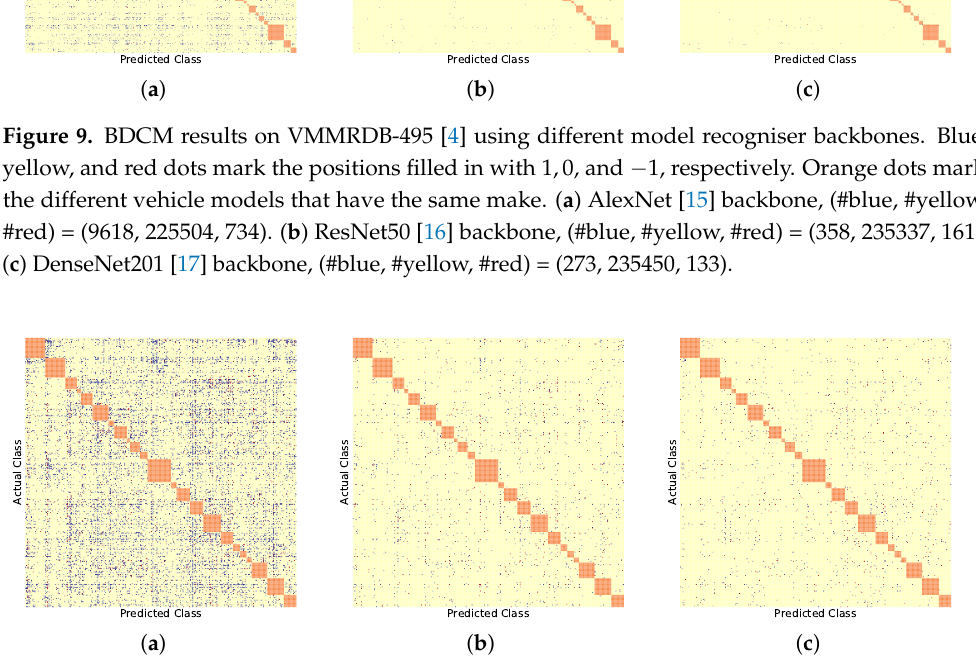
Figure 10. BDCM results on DVMM using different model recogniser backbones. Blue, yellow, and red dots mark the positions filled in with 1,0, and − 1, respectively. Orange dots mark the different vehicle models that have the same make. ( a ) AlexNet [15] backbone, (#blue, #yellow, #red) = (9946, 89061, 1663). ( b ) ResNet50 [16] backbone, (#blue, #yellow, #red) = (1087, 98861, 722). ( c ) DenseNet201 [17] backbone, (#blue, #yellow, #red) = (774, 99318,